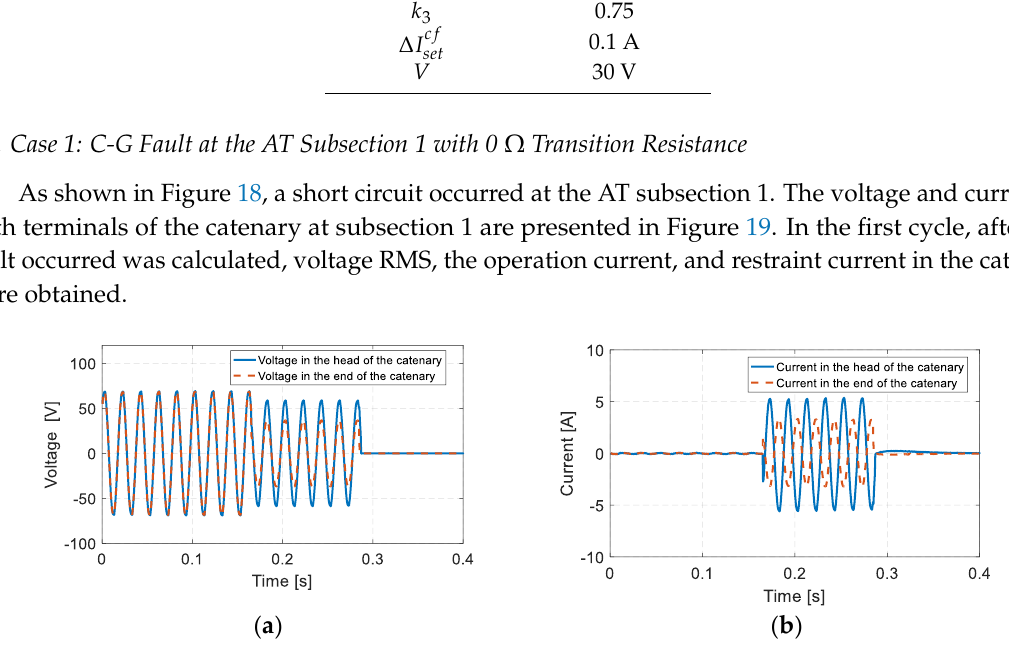
Figure 20. Voltage and current in the negative feeder at the AT subsection 3: ( a ) Voltage in two terminals of the negative feeder and ( b ) current in two terminals of the negative feeder.